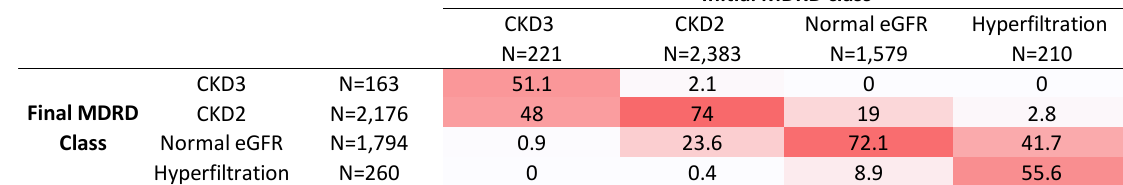
Figure 2. Changes in MDRD classes over time (%).